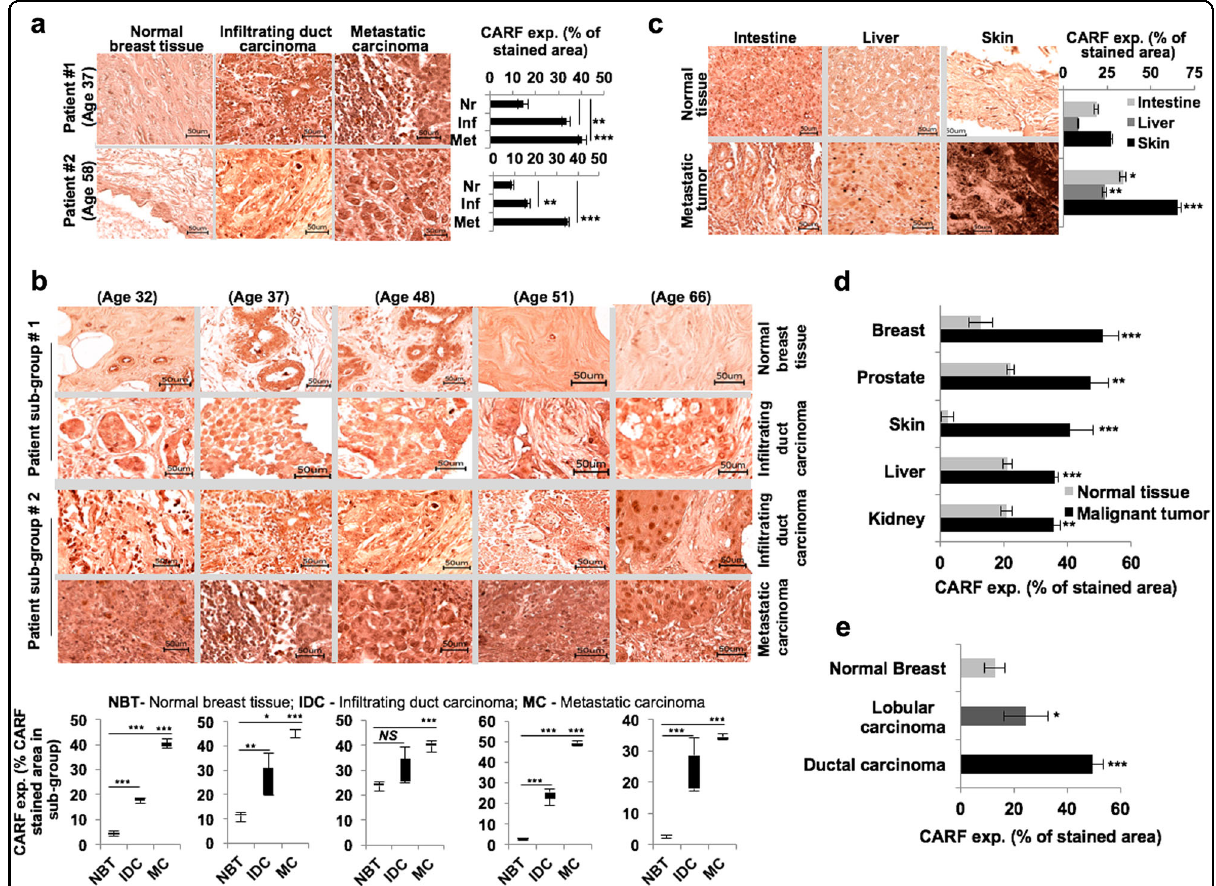
Fig. 2 CARF enrichment correlates with metastatic progression in clinical tumors. a Immunohistochemical staining showing CARF expression in normal, in fi ltrating, and metastatic breast cancer patient tumors; their quantitative levels shown on right. b , CARF levels in patients with normal to in fi ltrating (sub-group #1) and in fi ltrating to metastatic (sub-group #2) breast tumors in different age groups; quantitation shown below. c Expression of CARF in normal and metastatic tumor sections of intestine, liver and skin; quantitation shown on right. d Quantitation of CARF expression in normal and malignant breast, prostate, skin, liver, and kidney tumors sections; and in normal, lobular, and ductal breast cancer immunohistological sections retrieved from Human Protein Atlas ( e